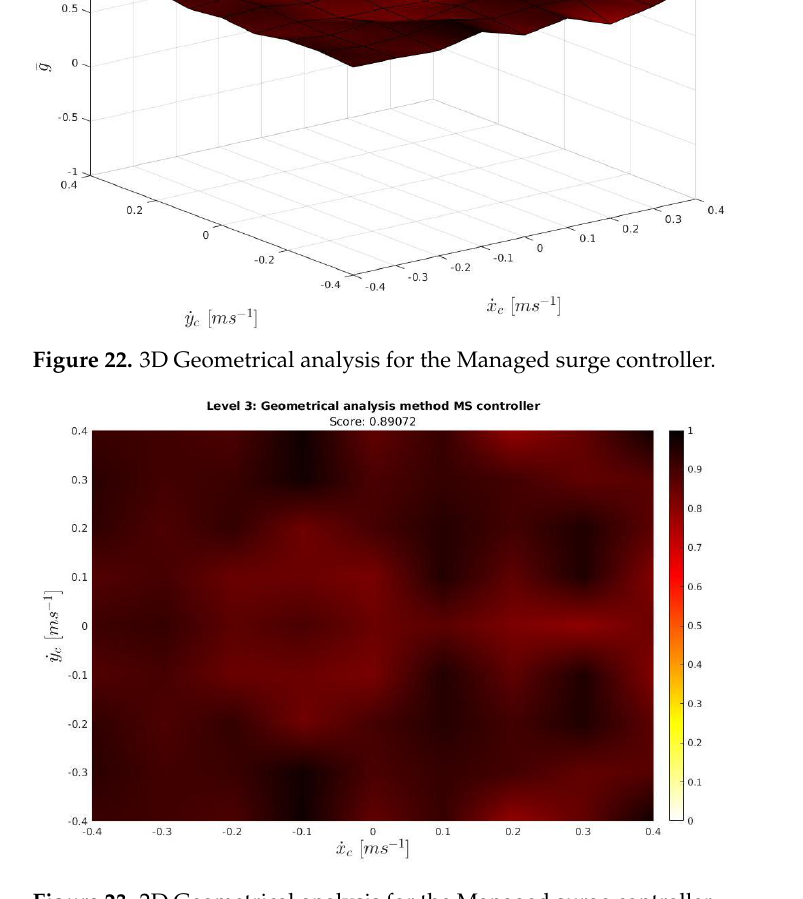
Figure 23. 2D Geometrical analysis for the Managed surge controller.